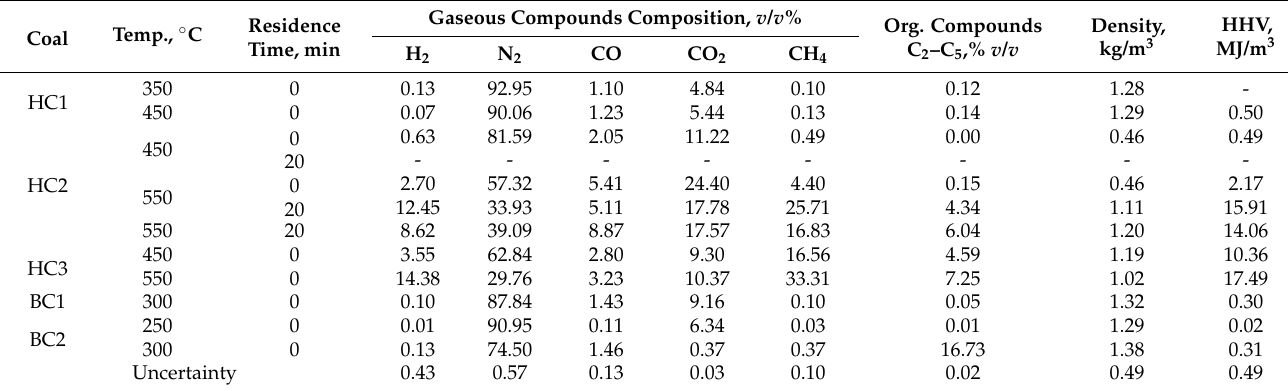
Table 7. Characteristics of the gaseous pyrolysis